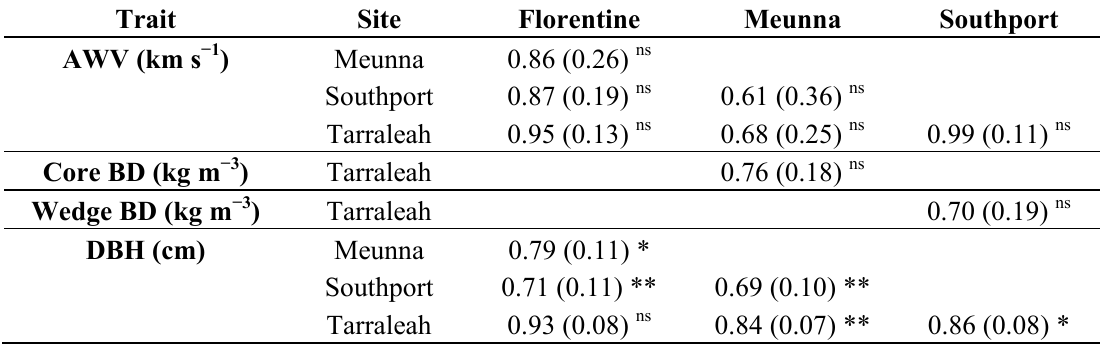
Table 5. Inter-site additive genetic correlations among the four Eucalyptus nitens progeny trial sites for acoustic wave velocity (AWV), basic density (BD) and diameter at breast height (DBH; 1.3 m) (standard errors shown in parentheses). The significance shown is for the test from one. All correlations were highly significantly different from zero ( p < 0.001) except for the standing tree AWV correlation between Southport and Meunna (0.61), which was not significant at the p < 0.05